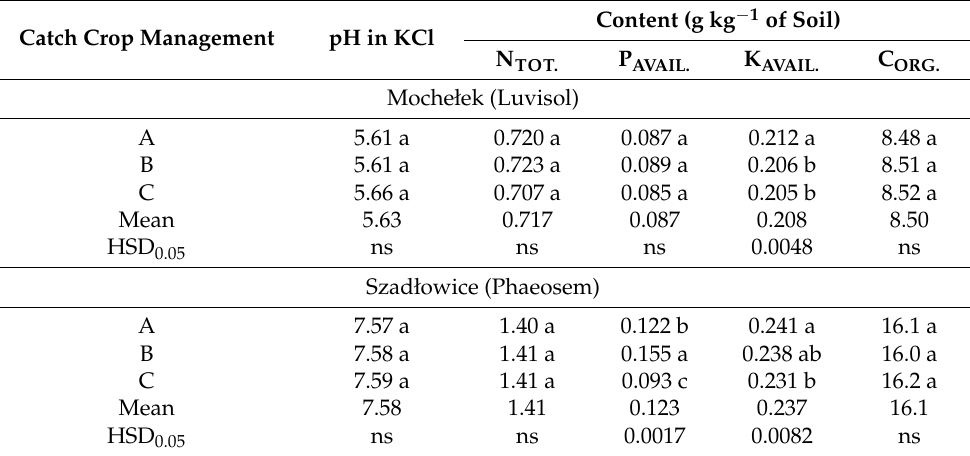
Table 5. Exchangeable acidity and the content of macroelements in soil before spring barley sowing— means for 2008 to 2010.